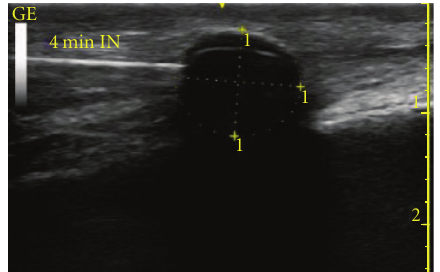
Figure 5: Cryolesion (diameter = 1.12 cm) at 4 minutes into the freeze cycle.